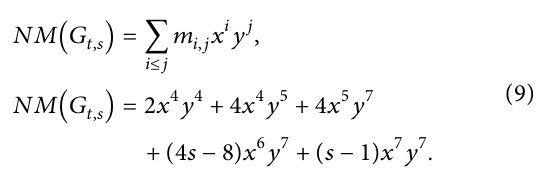
Figure 1: Graphene G